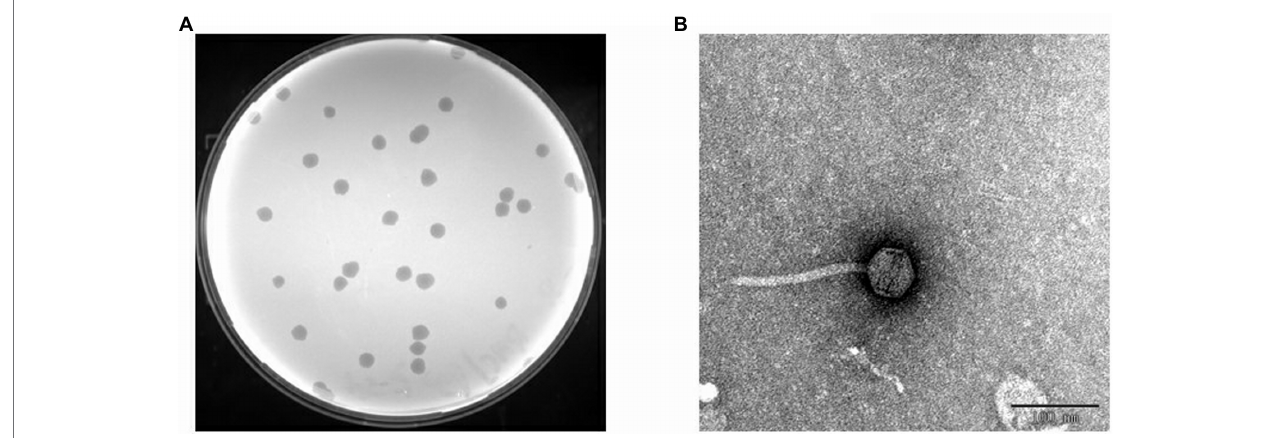
FIGURE 3 | Isolated phage BUCT603. (A) Plaques on double agar plate. (B) Electron micrographs of phage BUCT603.